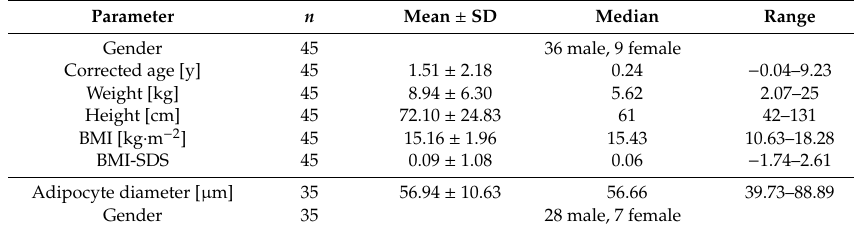
Table 1. Anthropometric parameters of the Ulm Childhood Adipose Tissue Collective. The data are given as mean ± SD, median, and range.